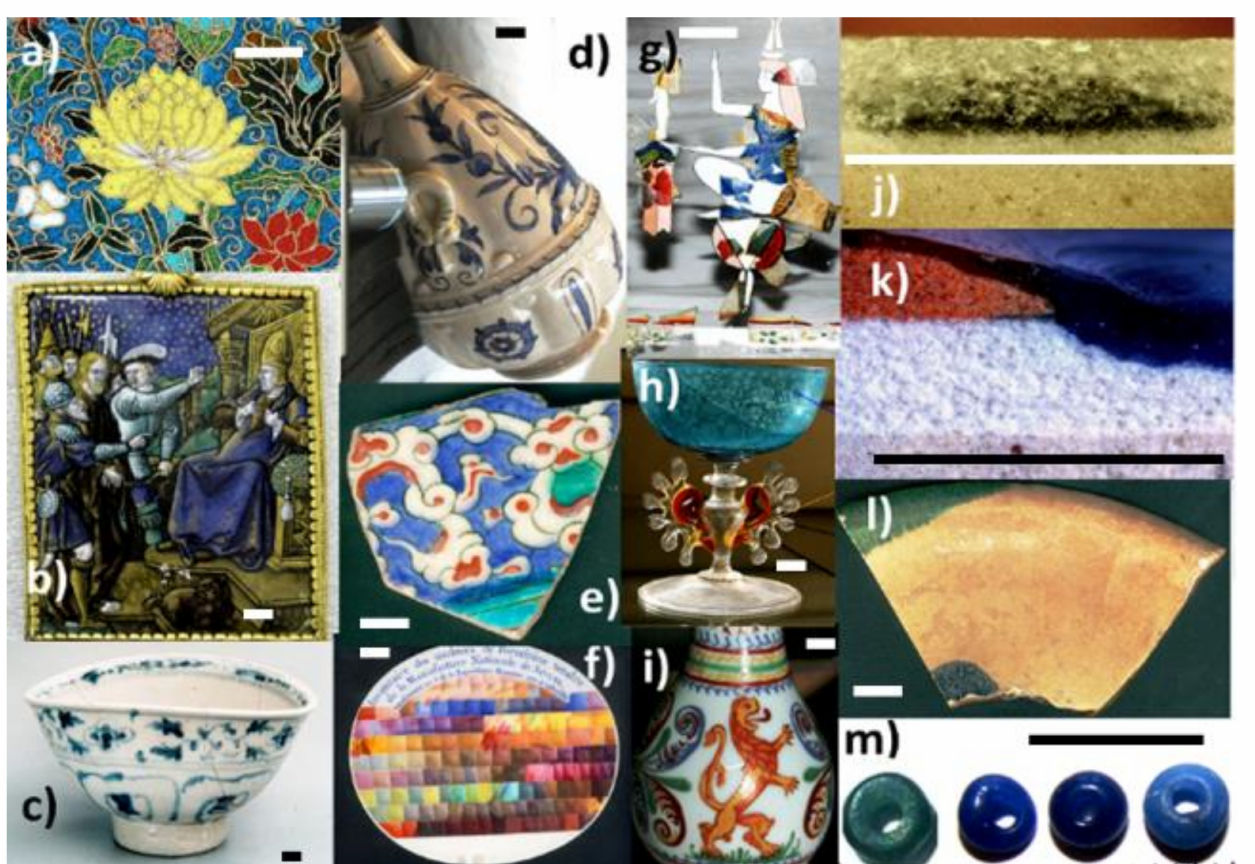
Figure 1. Variety of glassy artefacts coloured in blue and with blue d é cor: ( a ) Chinese Ming Dynasty cloisonn é enamel on copper alloy (detail of a box lid); ( b ) Limoges enamel on copper plate; ( c ) 15th-Century Vietnamese blue-and-white porcelain bowl; ( d ) Medici porcelain bottle (16th-Century); ( e ) Iznik tile (16th-Century); ( f ) test palette on soft-paste porcelain plate (early 19th-Century); ( g ) Ptolemaic/Roman enamelled glass (Begram Hoard, 1st-Century BCE to 1st-Century CE); ( h ) ‘ Façon de Venise ’ glass cup (16th–17th-Centuries); ( i ) ‘Bernard Perrot’ glass bottle imitating porcelain (17th–18th-Centuries, Orl é ans, France); ( j ) section of a qinghua Chinese porcelain showing blue d é cor drawn under the glaze; ( k ) section of an Iznik tile showing red and blue overglazes coated on the quartz-rich slip (white), the latter being coated on the (grey) stonepaste; ( l) Abbasid (9th-Century) pottery imitating Tang sancai excavated at Bassorah; ( m ) Khami-Indo-Pacific trade beads (15th–17th-Centuries). Collections from: Mus é e des arts d é coratifs, Paris ( a , b ); Cit é de la C é ramique-S è vres & Limoges ( d , f , h , i ); Mus é e des arts asiatiques-Guimet ( g ); Topkapi Palace Museum ( k ); ( m ) University of Pretoria; others ( c , e , j , l ) private collections (scale bar: 1